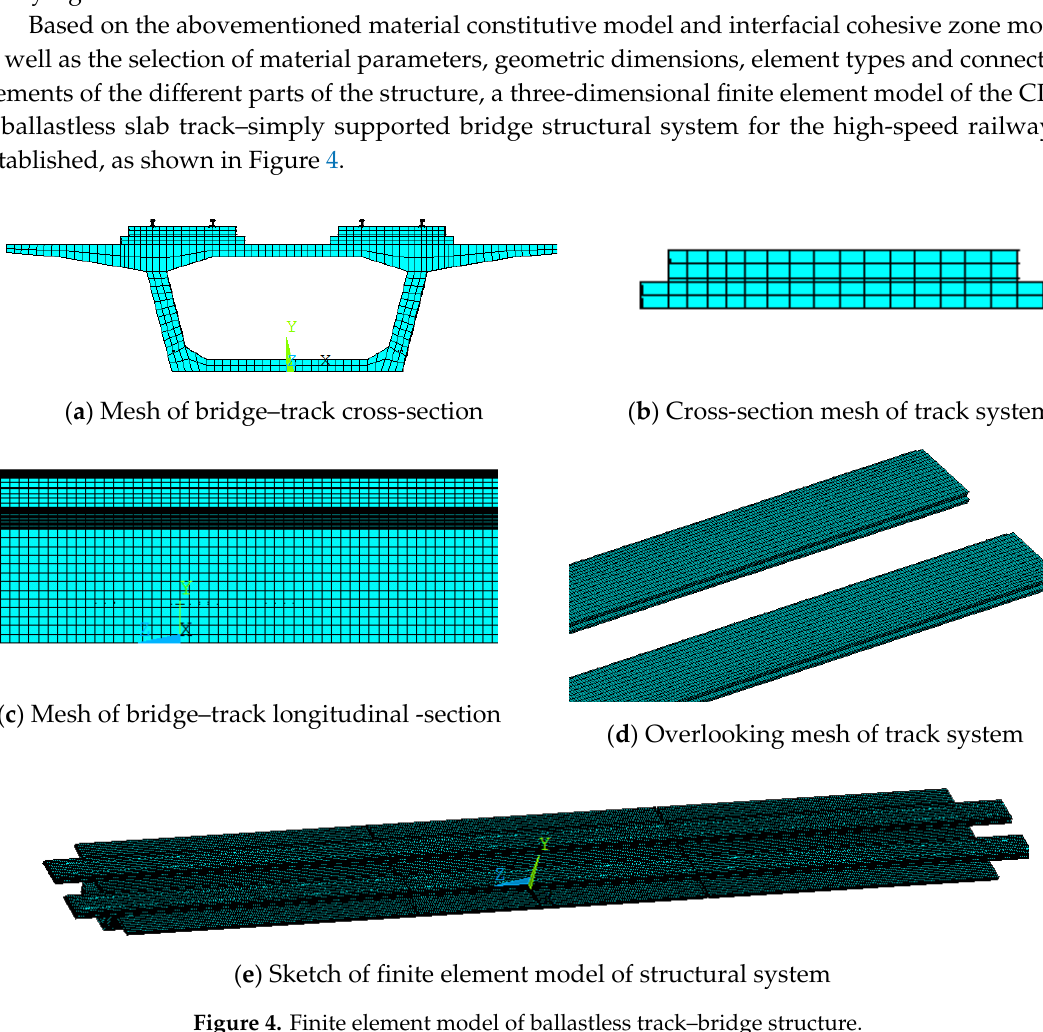
Figure 4. Finite element model of ballastless track–bridge structure.